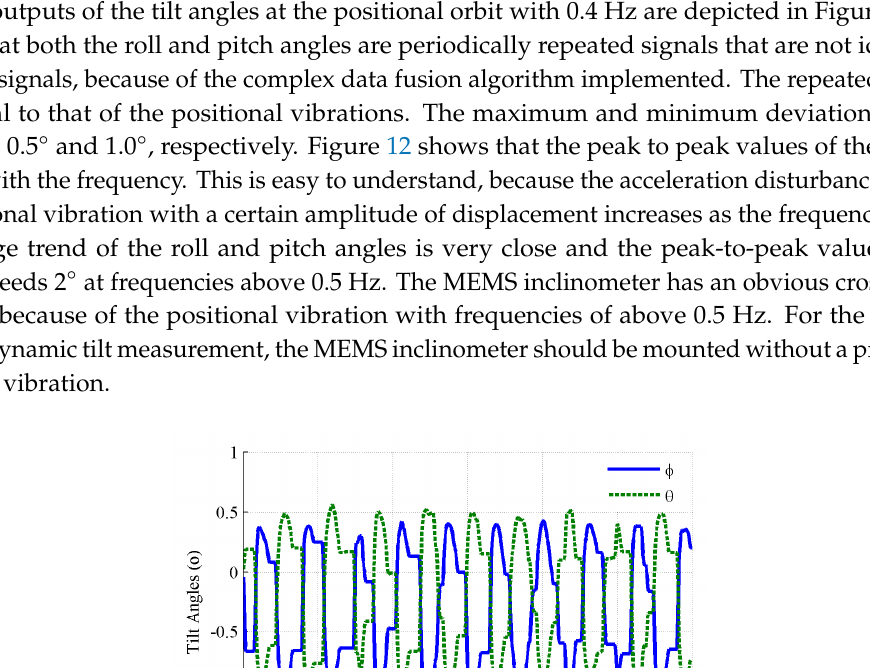
Figure 12. Peak-to-peak values of the tilt angles caused by cross-coupling. 4.3. Comparison with the Rotator An experiment comparison with the rotator was conducted in order to verify the effectiveness of the proposed method. The two-axis rotator was employed to sequentially generate a single tilt motion. As shown in Figure 13, the same MEMS inclinometer was mounted on the table of the rotator. The two axes of the rotator were firstly positioned so that the roll axis of the inclinometer was parallel with the outer axis of the rotator. By controlling the outer axis to angularly vibrate, the roll-axis sensitivities of the gyroscope and tilt sensing were determined. Then, the pitch axis of the inclinometer was tuned to be parallel with the outer axis of the rotator, by which the pitch-axis sensitivities of the gyroscope and tilt sensing were determined.